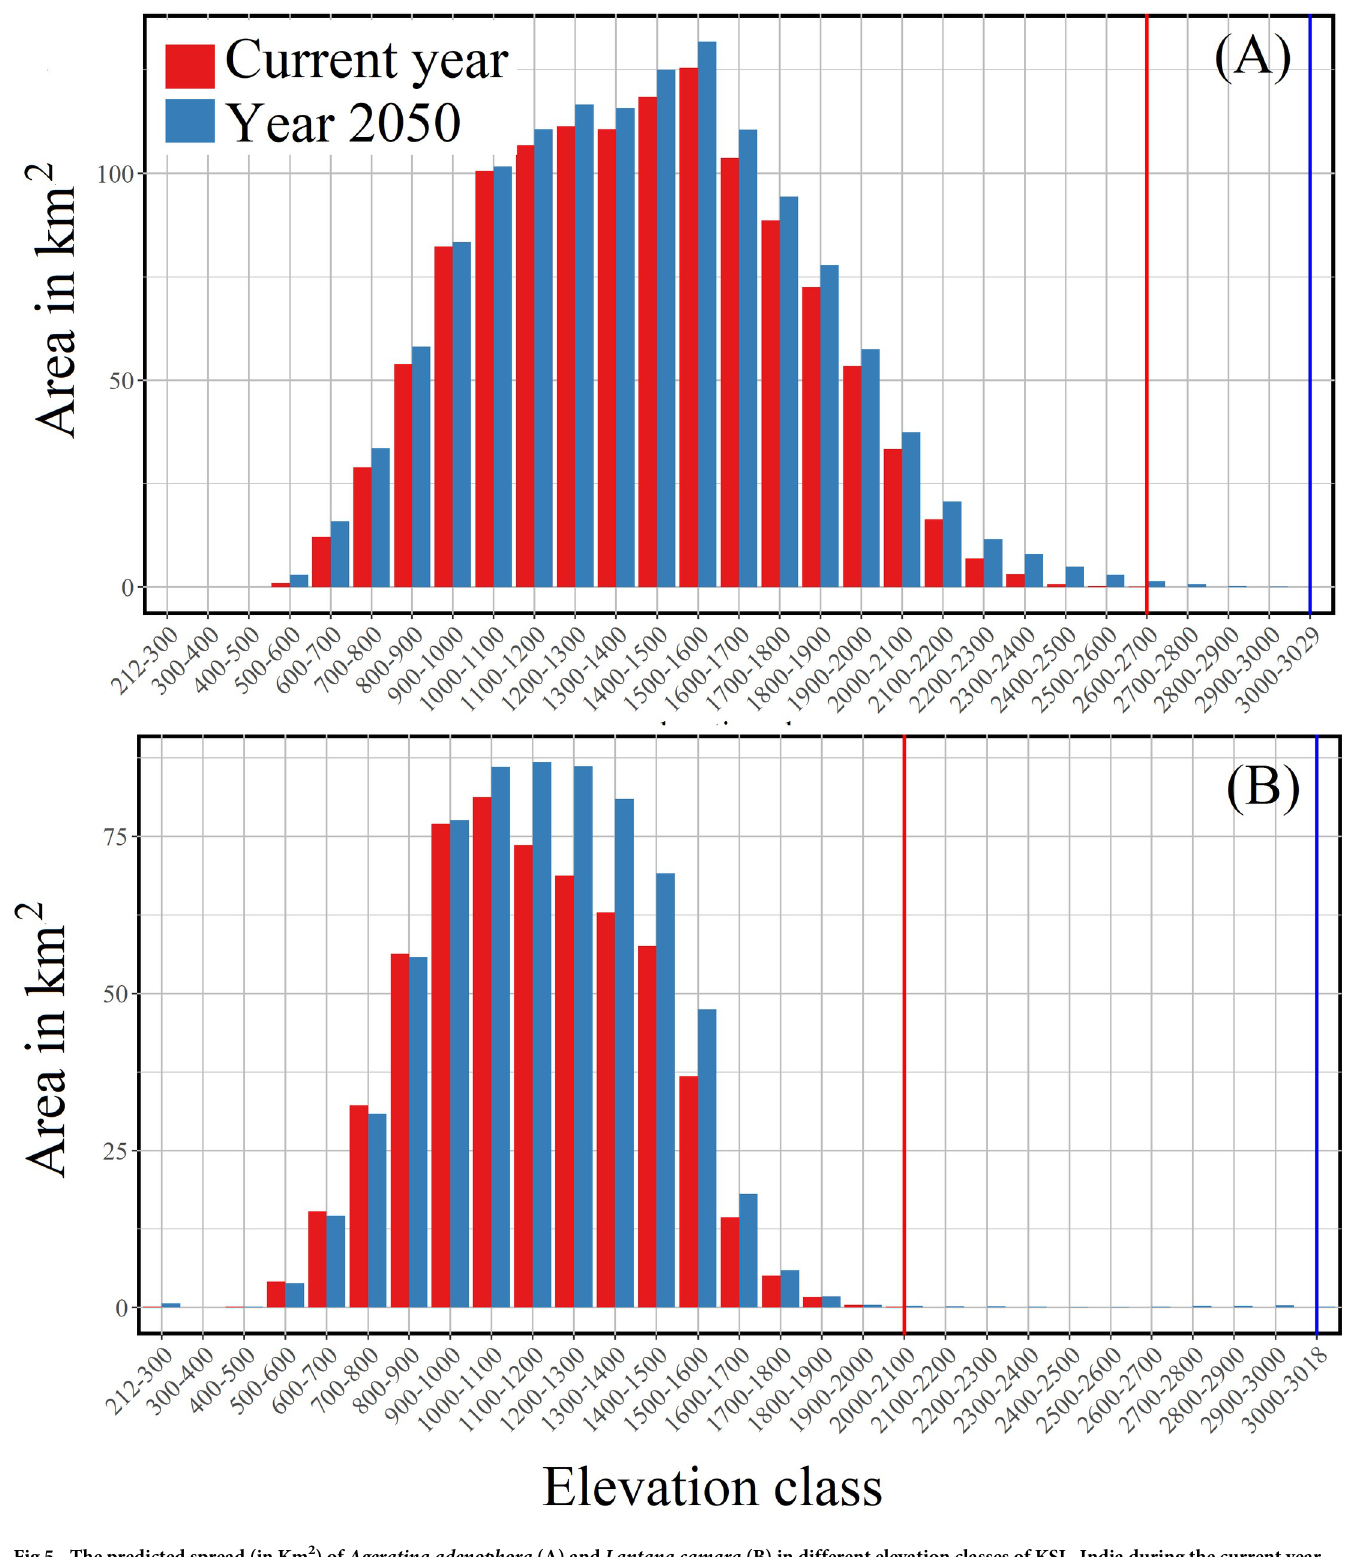
Fig 5. The predicted spread (in Km 2 ) of Ageratina adenophora (A) and Lantana camara (B) in different elevation classes of KSL–India during the current year and the year 2050.